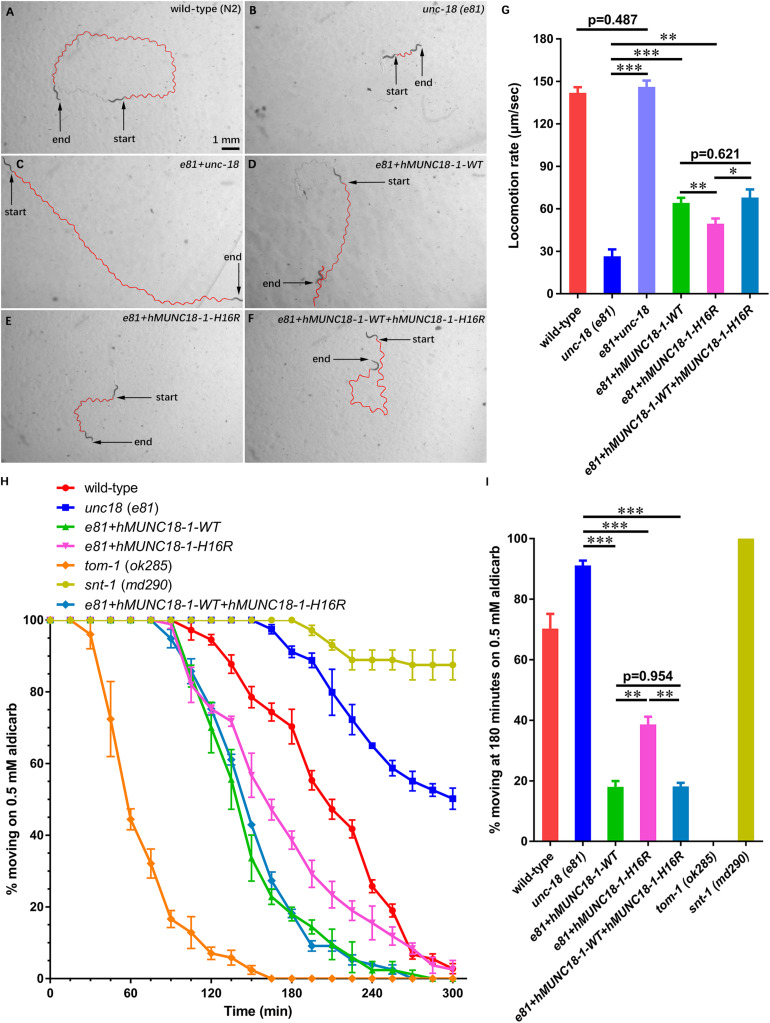
Human MUNC18-1 transgenic unc-18 (e81) C. elegans altered their locomotion and aldicarb resistance. (A–F) The locomotion trail of wild-type (A), unc-18 (e81) (B), e81 + unc-18
(C),
e81 + hMUNC18-1-WT (D),
e81 + hMUNC18-1-H16R (E) and e81 + hMUNC18-1-WT + hMUNC18-1-H16R (F) worms on NGM plate in 1 min. The traces of worms’ locomotion in 1 min are outlined in red, start and end represent the start and end position of individual worm in 1-min recording, respectively. (G) The average locomotion rate (μm/sec) of wild-type (n = 16), unc-18 (e81) (n = 15), e81 + unc-18 (n = 17), e81 + hMUNC18-1-WT (n = 33), e81 + hMUNC18-1-H16R (n = 35), and e81 + hMUNC18-1-WT + hMUNC18-1-H16R (n = 19) strains. * means p < 0.05, ** means p < 0.01, *** means p < 0.001. (H) The paralysis time-course of unc-18 (e81), e81 + unc-18, e81 + hMUNC18-1-WT, e81 + hMUNC18-1-H16R and e81 + hMUNC18-1-WT + hMUNC18-1-H16R worms on NGM plate containing 0.5 mM aldicarb (n = 3 repeats). tom-1 (ok285) strain and snt-1 (md290) strain are used as hypersensitivity control and super-resistance control, respectively. (I) The survival ratio of 7 worm strains on NGM plate containing 0.5 mM aldicarb at 180 min (n = 3 repeats), ** means p < 0.01, *** means p < 0.001.